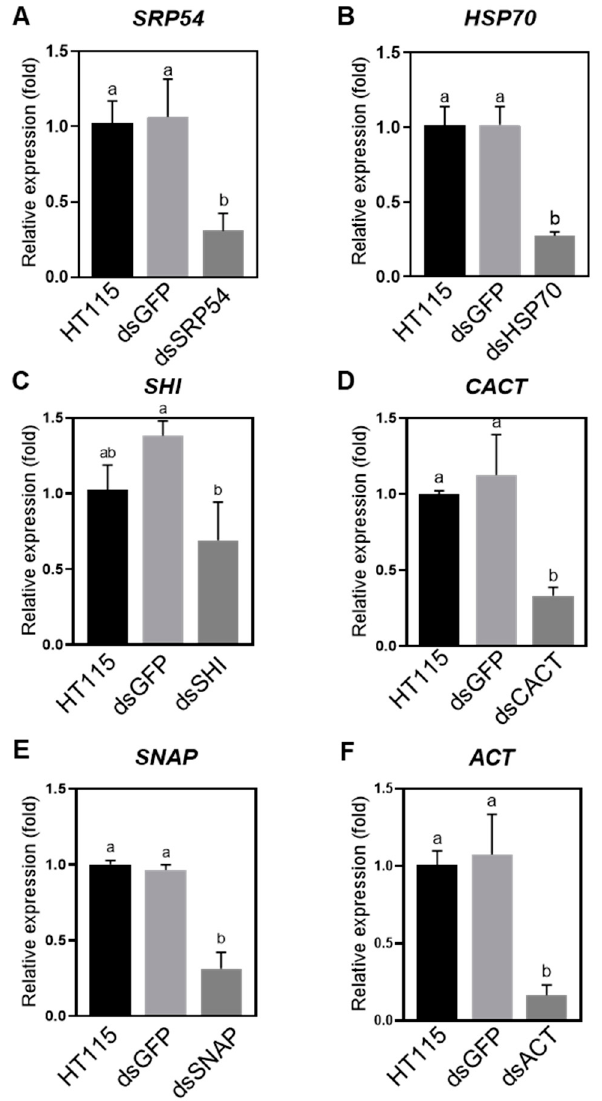
Figure 3. Relative gene expression of Plagiodera versicolora larvae (n = 40) after being fed for 3 days with willow leaves painted with bacteria-expressed dsRNAs targeting indicated genes: ( A ) SRP54 . ( B ) HSP70 . ( C ) SHI . ( D ) CACT . ( E ) SNAP . ( F ) ACT . Relative expression of indicated genes were normalized using RPS18 as a reference gene. Bars on columns indicate the standard error (SE). Different letters on the columns mean significant difference by the Tukey at a 5% significance level.